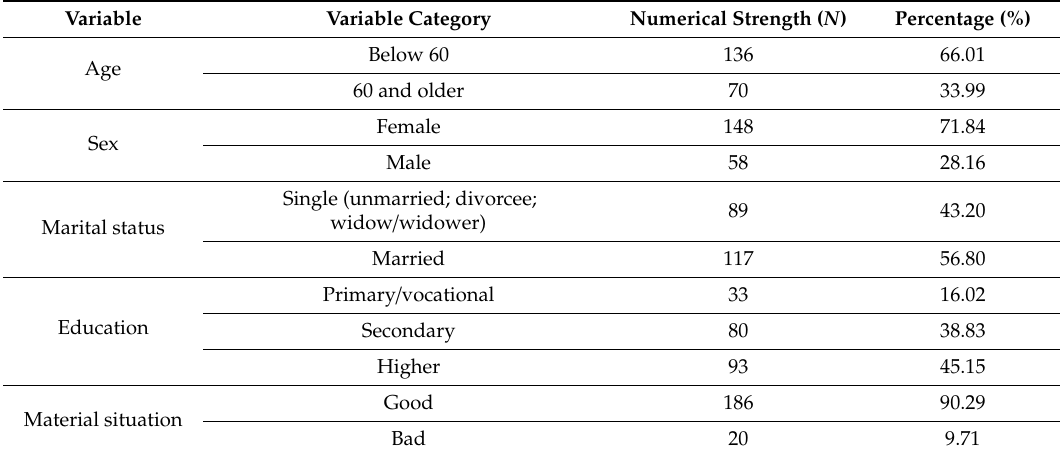
Table 1. Characteristic of the investigated